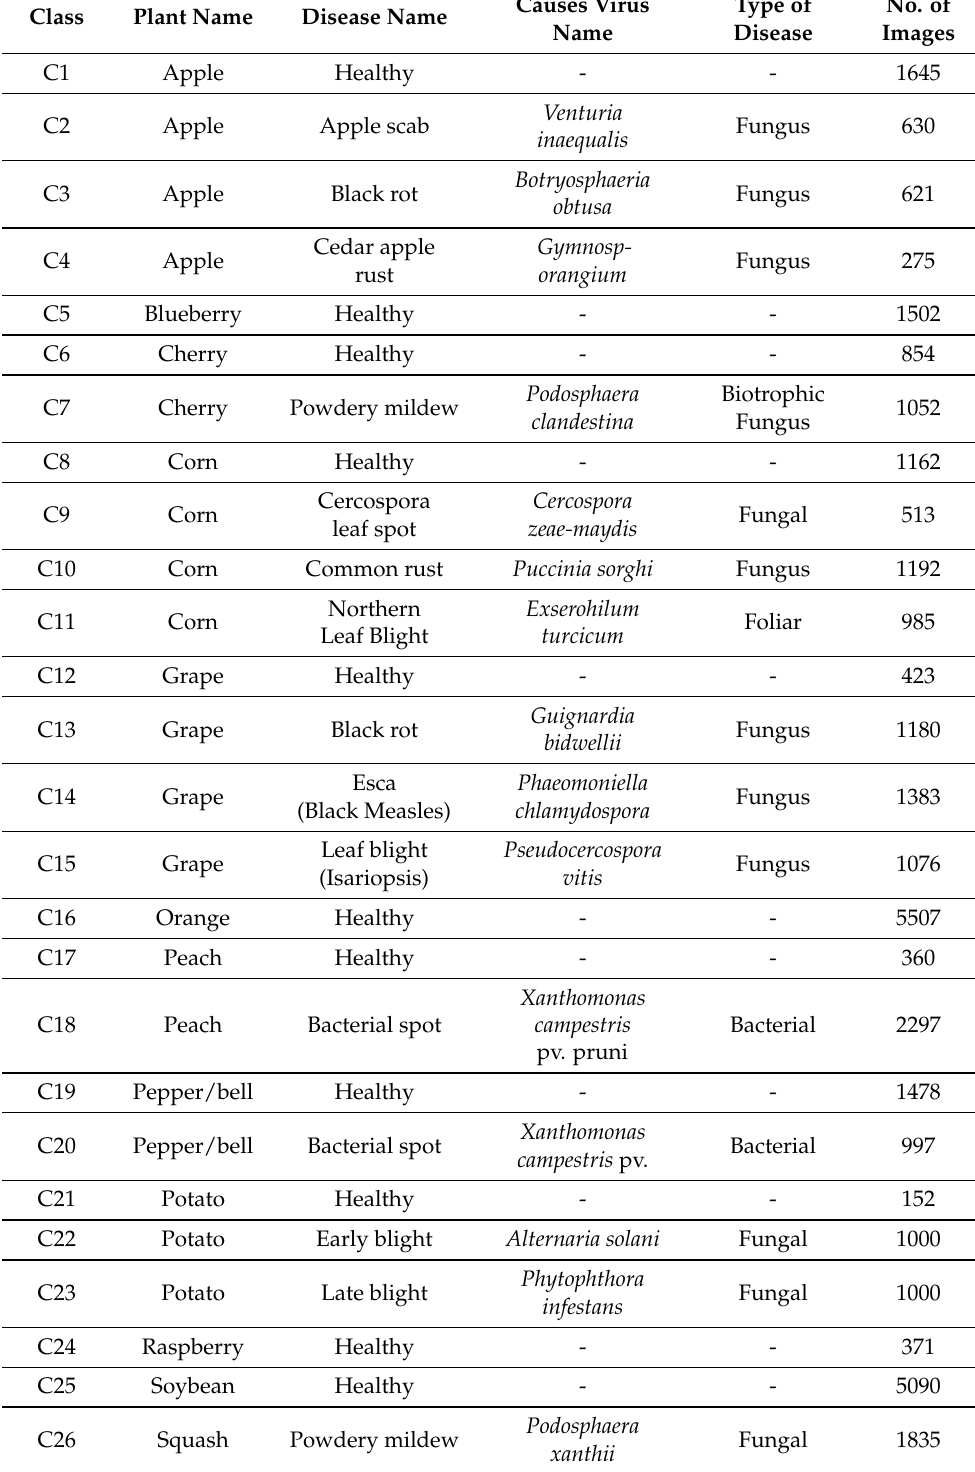
Table 5. Detailed description of PlantVillage dataset with relative